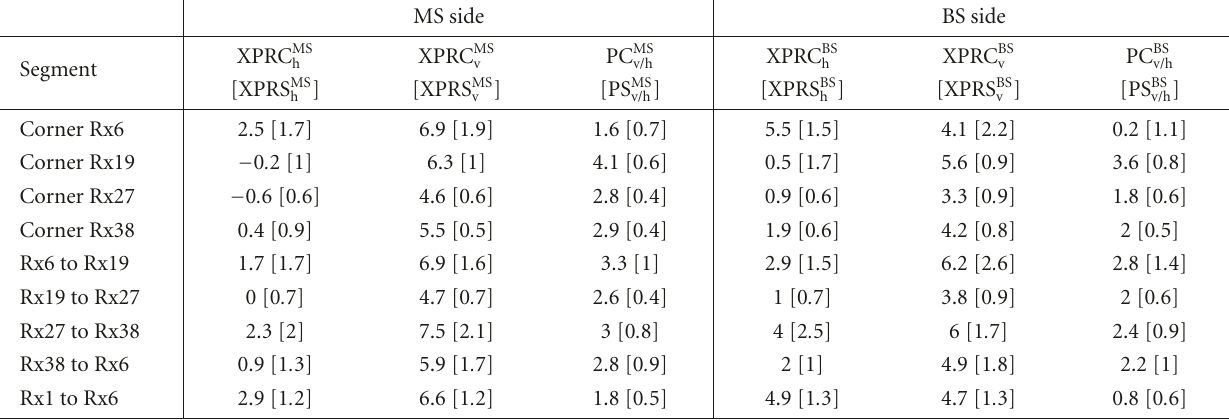
Table 4: XPRC and XPRS of the DMCs in dB.